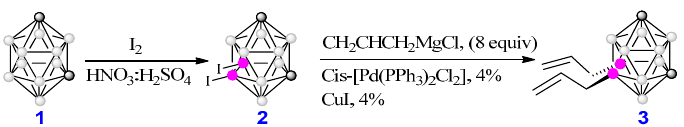
Figure 2. Schematic view of the two types of radially expanded tetrabranched core for constructing dendritic structures. Circles colour: dark grey correspond to C c -H bonds, black to C atoms, pink to Boron atoms and grey to B-H vertexes in the tetra-branched